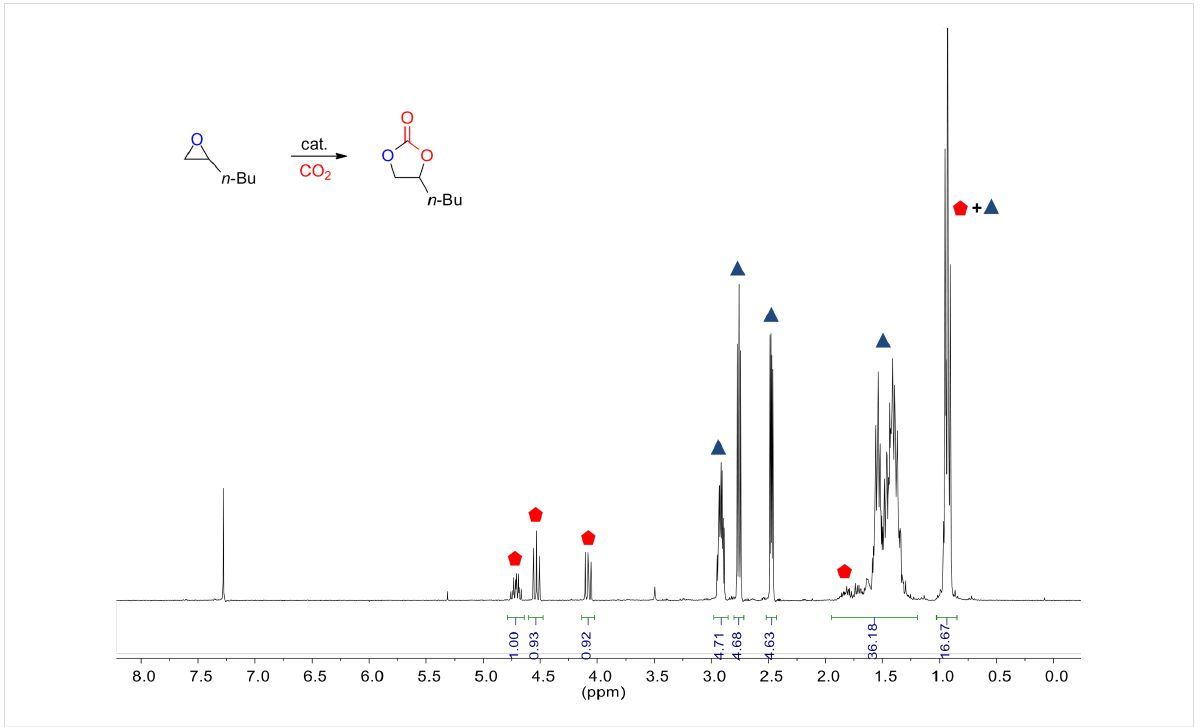
Figure 2: Typical 1 H NMR spectrum of a sample of a crude mixture in CDCl 3 (300 MHz) at rt.